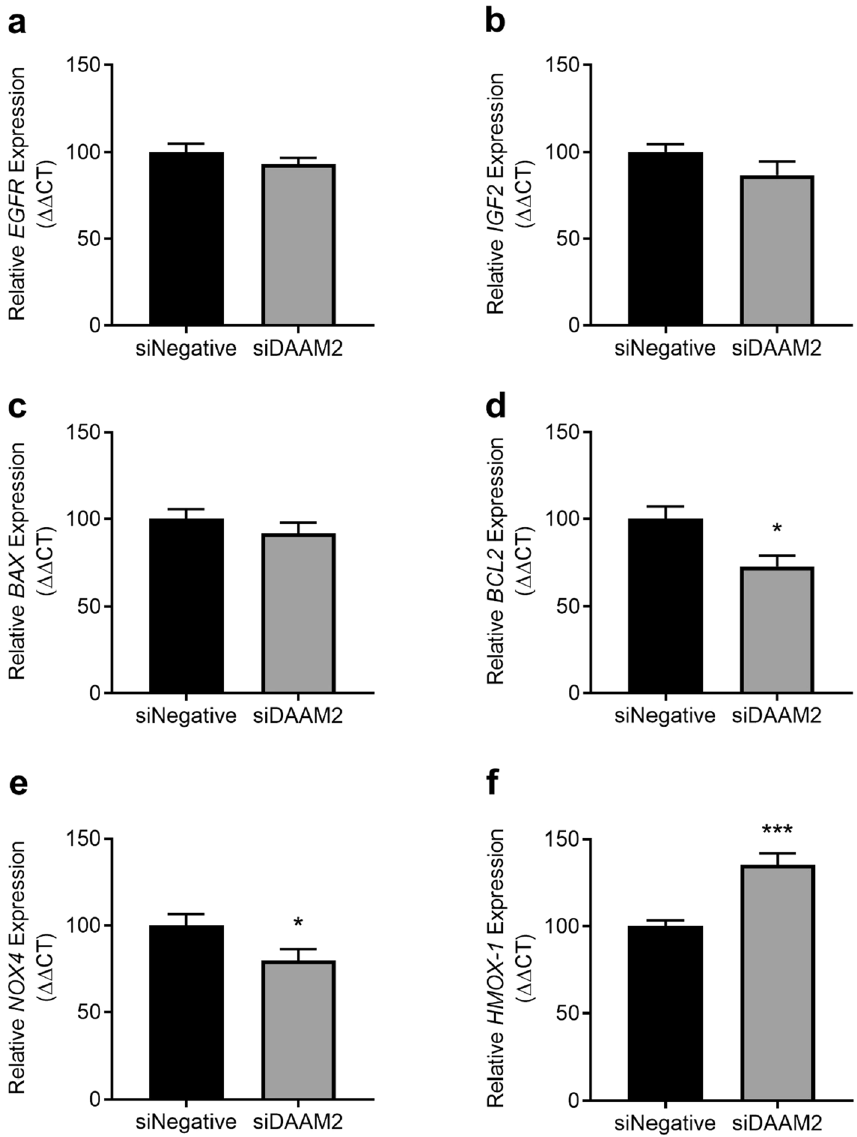
Figure 6. Effect of DAAM2 knockdown on expression of cell growth, apoptosis and oxidative stress genes under hypoxia (1% O 2 ). Knockdown of DAAM2 with siRNA (siDAAM2) significantly decreased ( d ) BCL2 , ( e ) NOX4 and increased ( f ) HMOX-1 mRNA expression compared to the negative siRNA control (siNegative), but had no effect on ( a ) EGFR , ( b ) IGF2 or ( c ) BAX . Data presented as fold change from control ± SEM. *p < 0.05, ***p < 0.001. n = 3 experimental replicates (each sample from a different patient), with each experiment performed in